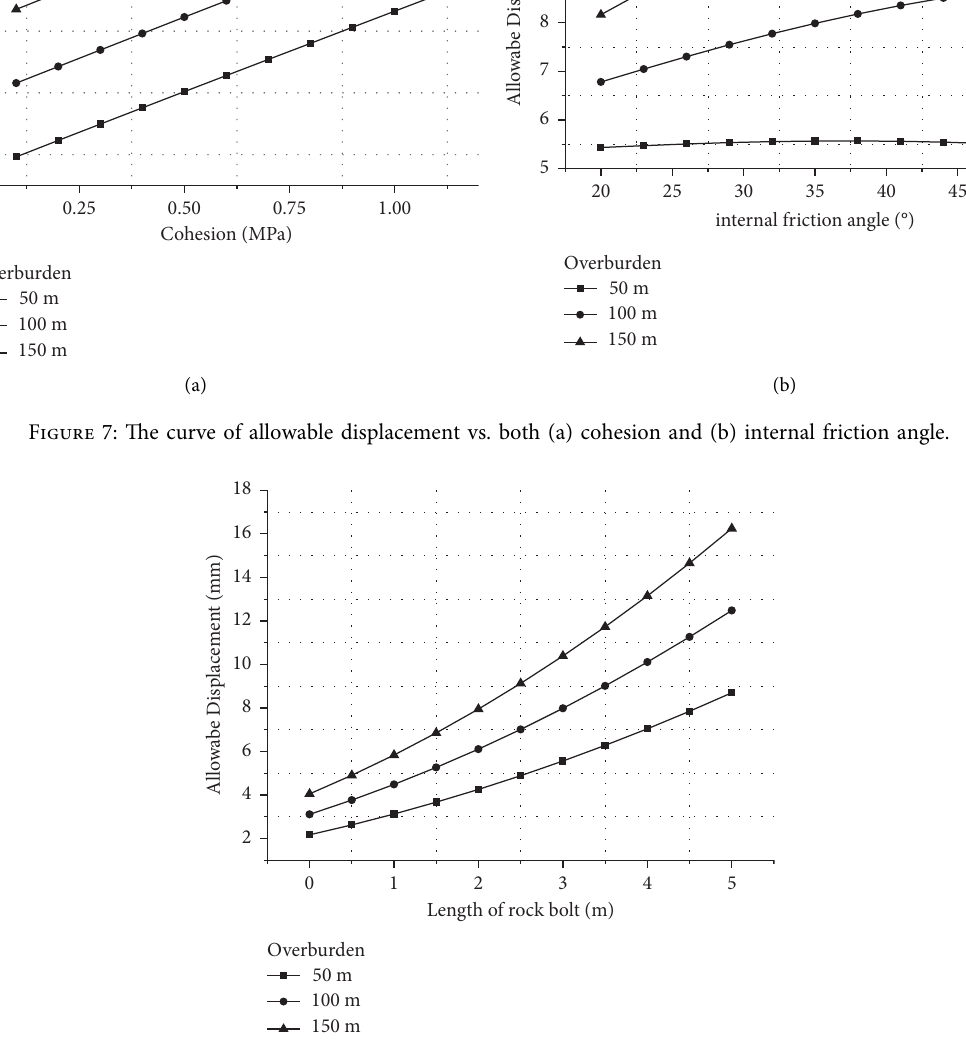
Figure 8: The curve of allowable displacement vs. the length of rock bolt. Table 3: Physical and mechanical parameters of surrounding rock mass graded from III to V. Rock